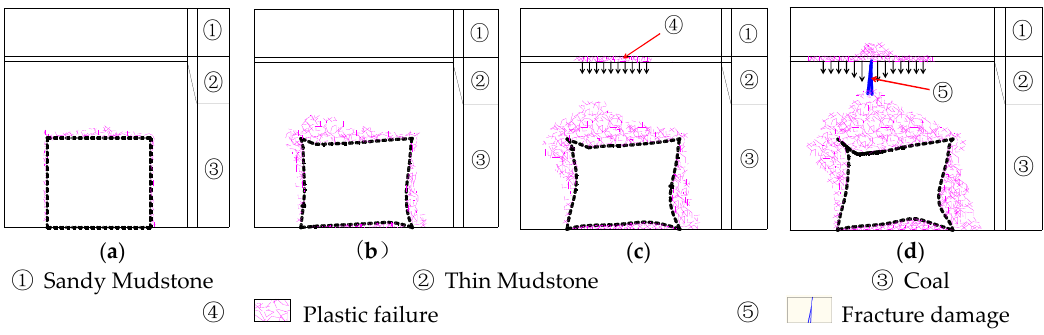
Energies 2019 , 12 , x FOR PEER REVIEW Figure 13. Plastic zone development process of roadway compound roof. Figure 13. Plastic zone development process of roadway compound roof.